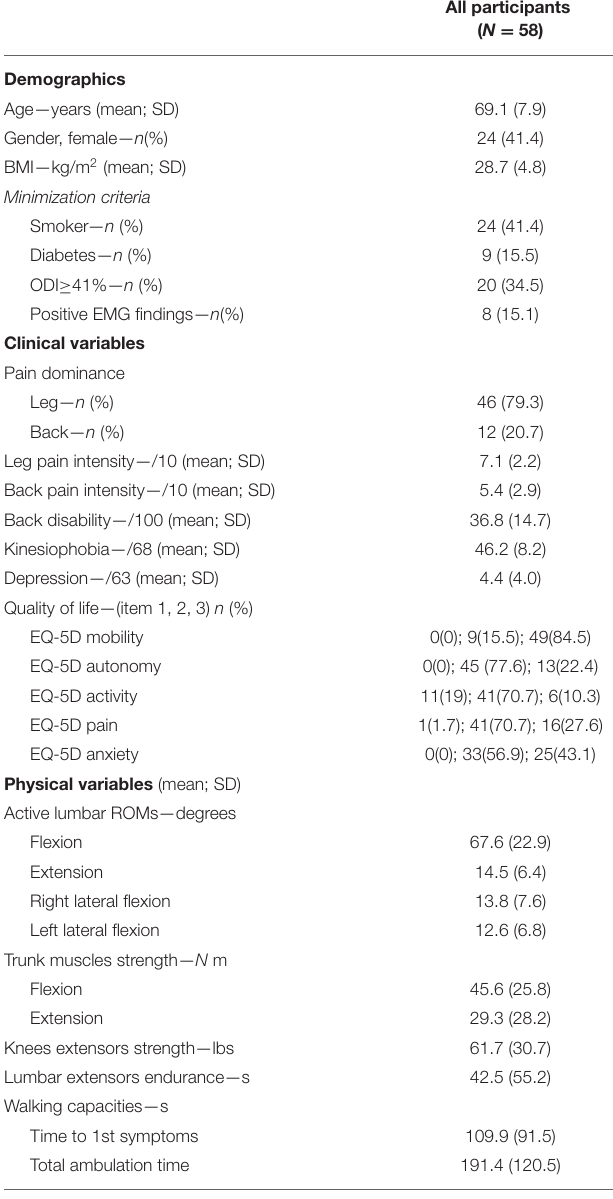
TABLE 2 | Result of the multivariate binary logistic regression All participants ( N = 58)